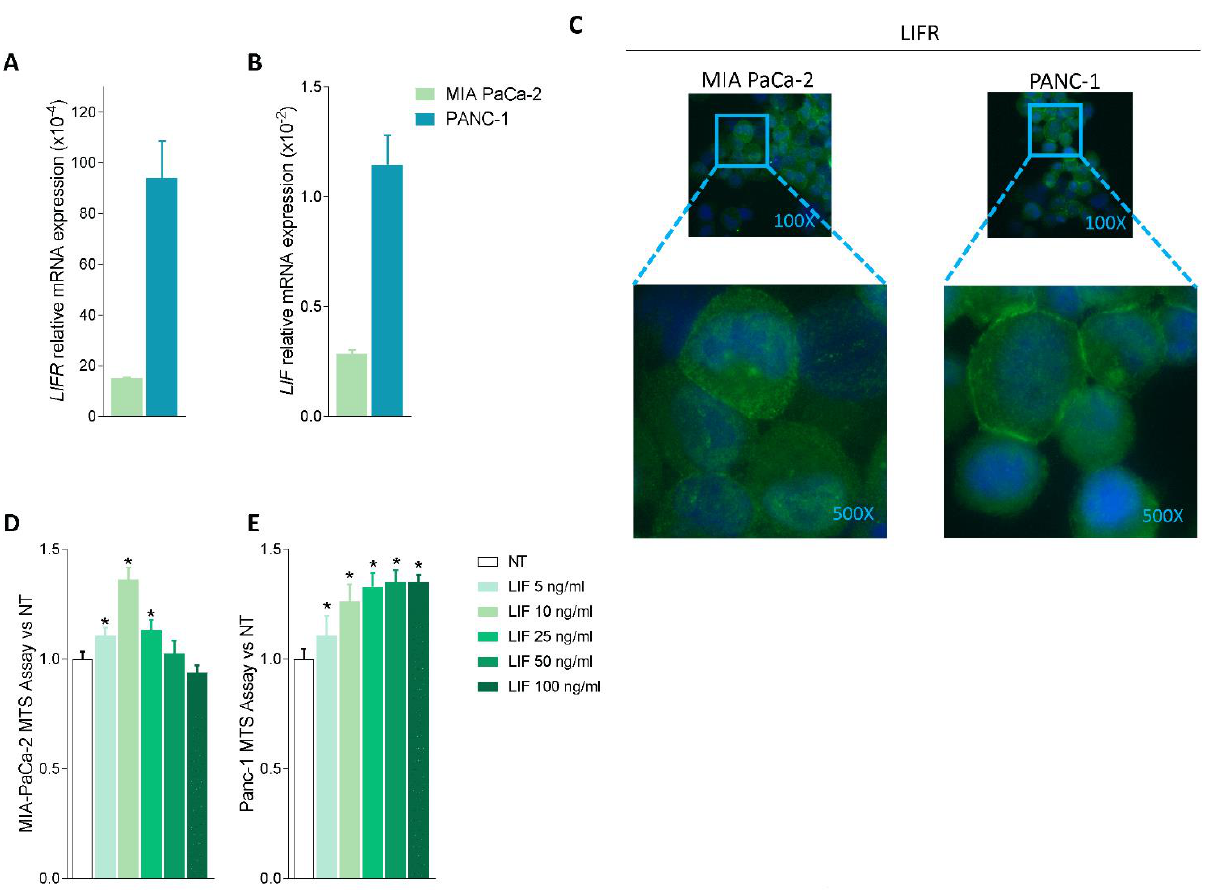
Figure 2. LIF/LIFR expression is modulated in MIA PaCa-2 and PANC-1 cells and LIF induces cell proliferation. Relative mRNA expression of ( A ) LIFR and ( B ) LIF in MIA PaCa-2 (green) and PANC-1 (light blue) cell lines. ( C ) Immunofluorescence analysis of LIFR expression in PANC-1 and MIA PaCa-2 cell lines (magnification 100 × and 500 × ). Dose-response curve of LIF (5, 10, 25, 50, 100 ng/mL) determined using MTS assay on ( D ) MIA PaCa-2 and ( E ) PANC-1 cell lines. Each value is expressed relative to the non-treated (NT) value, which is arbitrarily set to 1. Results are the mean ± SEM of 10 samples per group. * p < 0.05.